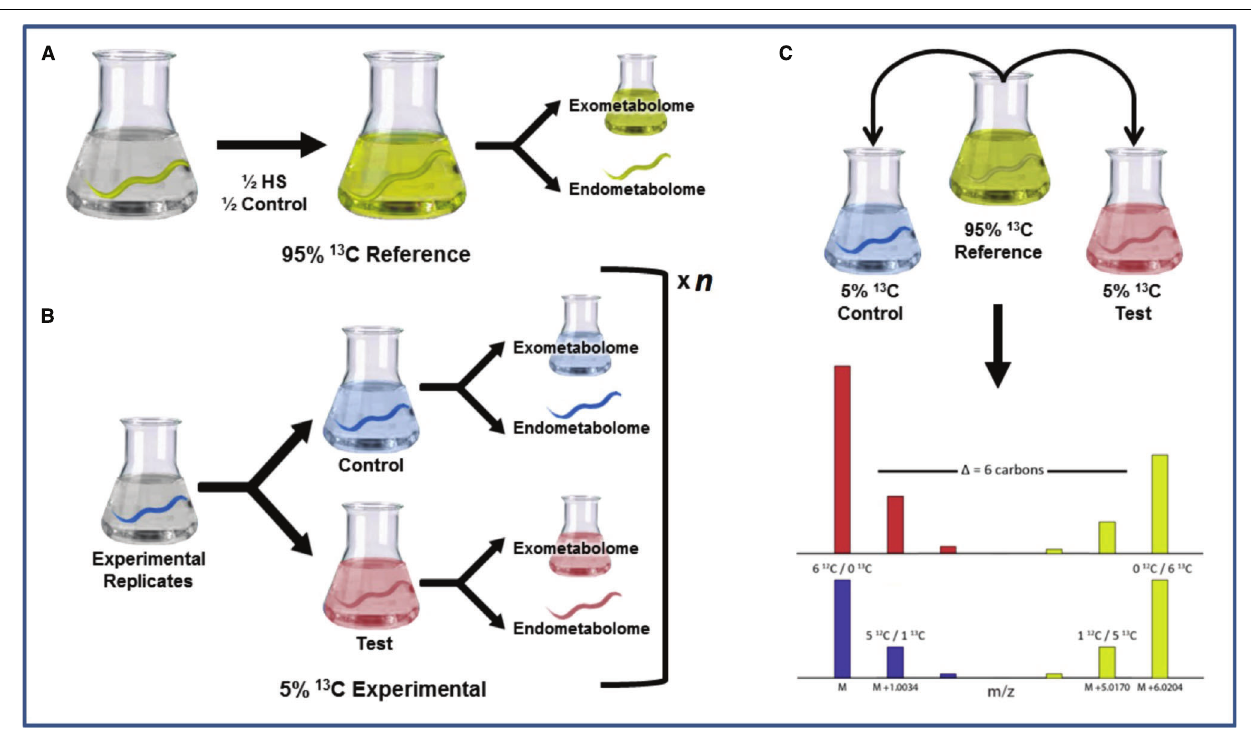
FIGURE 3 | Experimental design to compensate for isotopic effects. (A) In this experiment, the 95% 13 C population is mixed with replicates of both experimental and control groups and serves as an internal 13 C metabolic reference. (B) Both test and control populations are then labeled with 5% 13 C. (C) The 95% 13 C reference is combined